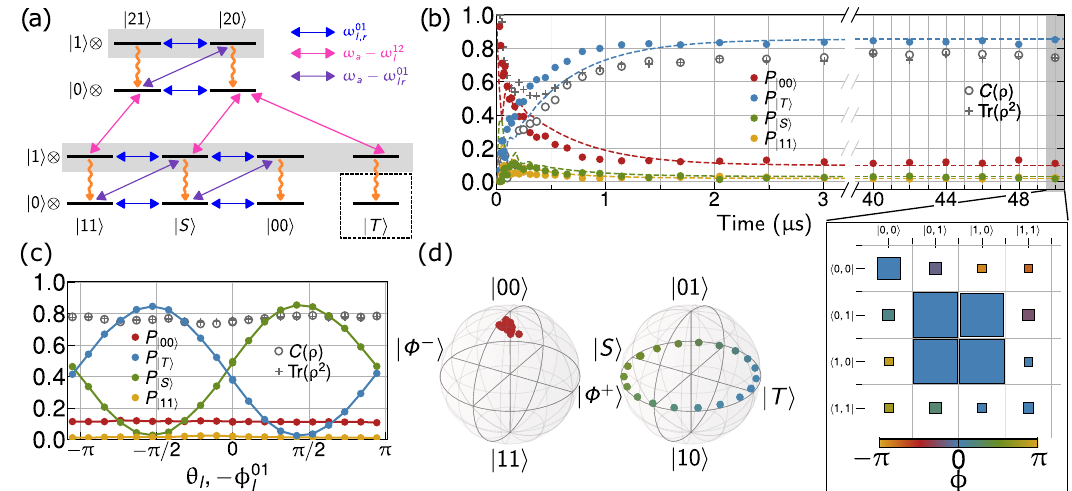
(purple), g 12 (magenta), and κ (orange). Only the fi rst Fig. 3 Stabilization protocol and results. a Energy level diagram showing the action of Ω l , r (blue), g 01 l ; r l ; r two energy levels of the resonators are shown for clarity. b Stabilization trajectory for transmons initialized in 00 j i obtained for Ω l , r = 2 π × 7.2 MHz, g 01 ¼ 2 π ´ 7 : 5 MHz, g 12 ¼ 2 π ´ 13 : 1 MHz, κ = 2 π × 4.73 MHz, showing target state (here T j i ) fi delity of 84% fi delity stabilized for 50 μ s. The dashed line l l ; r corresponds to trajectories obtained using master equation simulations. The density matrix at t = 50 μ s, reconstructed using quantum state tomography, shows that most of steady-state error is accounted for by decay into 00 j i . The size of the squares in the tomogram represent the magnitude, while the color represents the phase of the density matrix element. c Coherent control of the stabilized state, with simultaneous tuning of the phases of Rabi ( Ω l ) and parametric drives ( g 01 ), maintaining ϕ 01 þ θ l ¼ 0. The populations are shown at a fi xed time t = 2 μ s as a function of drive phase and remaining drive l l phases fi xed. The average purity and concurrence over the 2 π rotation are 77%. d Two-qubit Bloch sphere representations for (normalized) projections of steady state in odd- and even-parity manifolds.